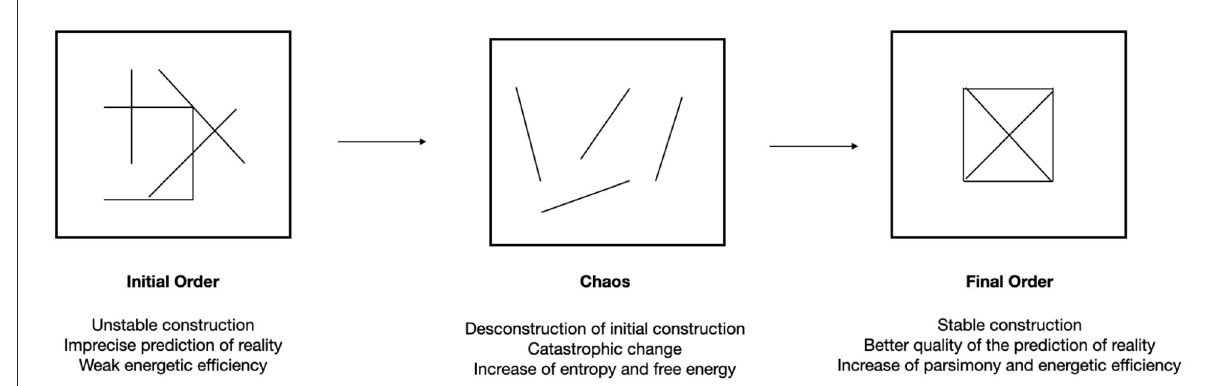
FIGURE2 Metaphoric representation of the evolution of psychological functioning during a psychoanalytic therapy from an initial order to a final order after a more chaotic and entropic